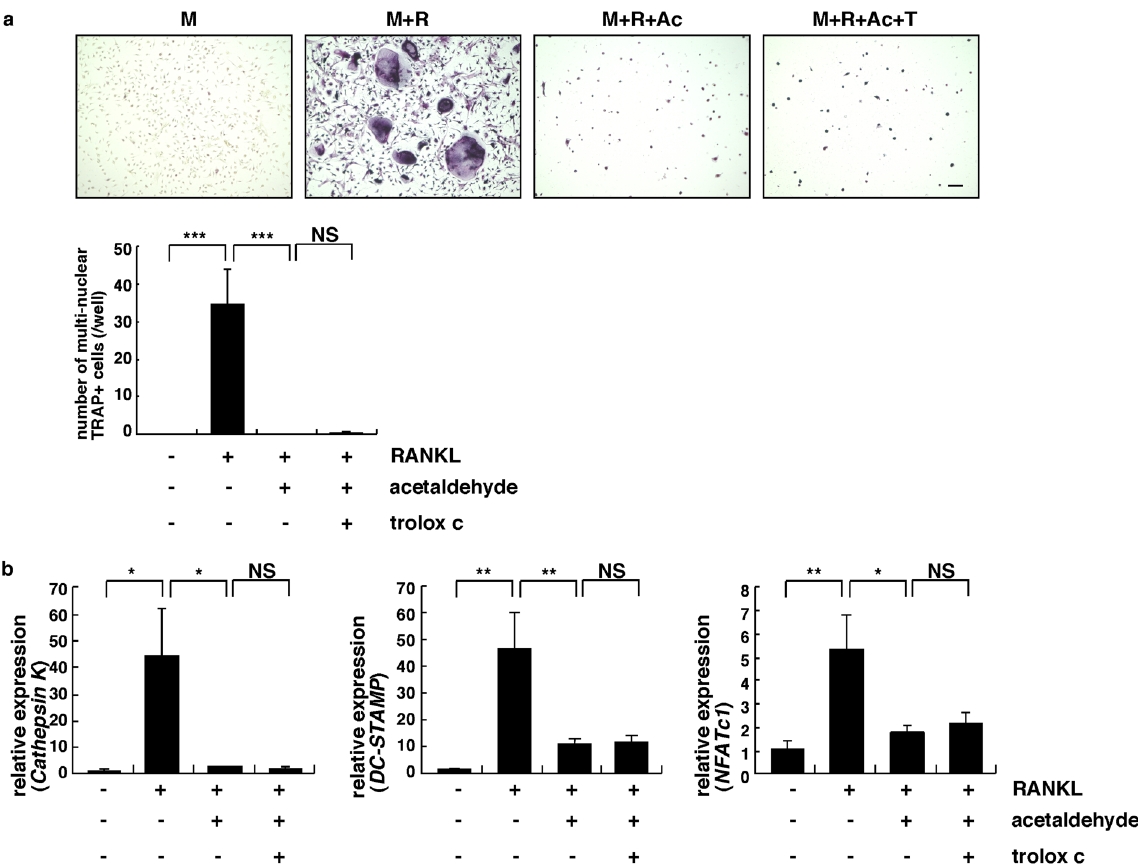
Figure 6. Osteoclast differentiation is inhibited by acetaldehyde and cannot be rescued by anti-oxidant treatment. ( a , b ) Wild-type mouse bone marrow-derived osteoclast progenitors were cultured in the presence of M-CSF (50 ng/ml) or M-CSF (25 ng/ml) plus RANKL (25 ng/ml) with or without 0.04% acetaldehyde and in the presence or absence of the anti-oxidant Trolox C (40 µ M) for 5 days. Cells were then subjected to TRAP staining ( a ) or realtime PCR ( b ). Multi-nuclear TRAP-positive cells containing more than five nuclei were scored as osteoclasts ( a ). Data represent mean number of multi-nuclear TRAP-positive cells/well ± SD ( n = 5). Realtime PCR data represent mean Cathepsin K , NFATc1 or DC-STAMP expression relative to β -actin ± SD ( n = 3). *** P < 0.001. Representative data of two independent experiments is